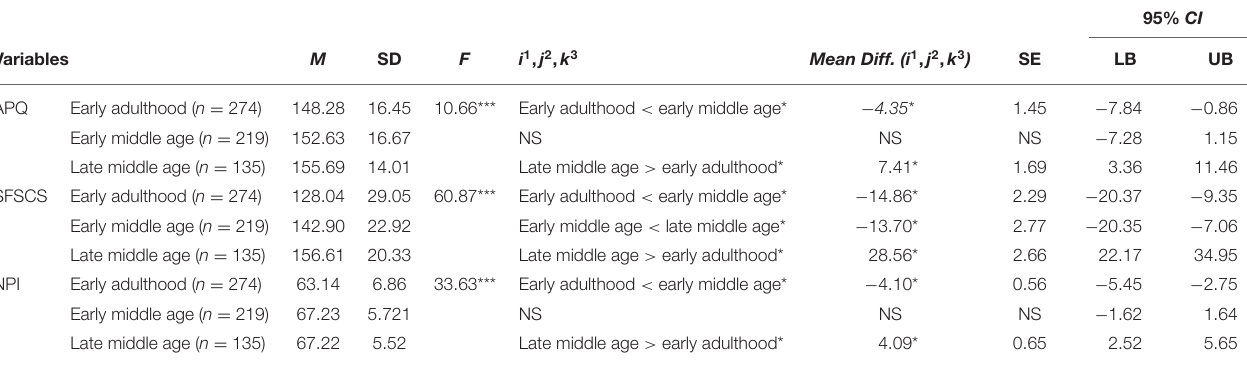
TABLE 5 | Analysis of variance of adult’s age (early adulthood: 21–30 years old, early middle age: 31–40 years old, and late middle age: 41–50 years old) on perceived parenting, self-concept, and narcissism ( N = 628).